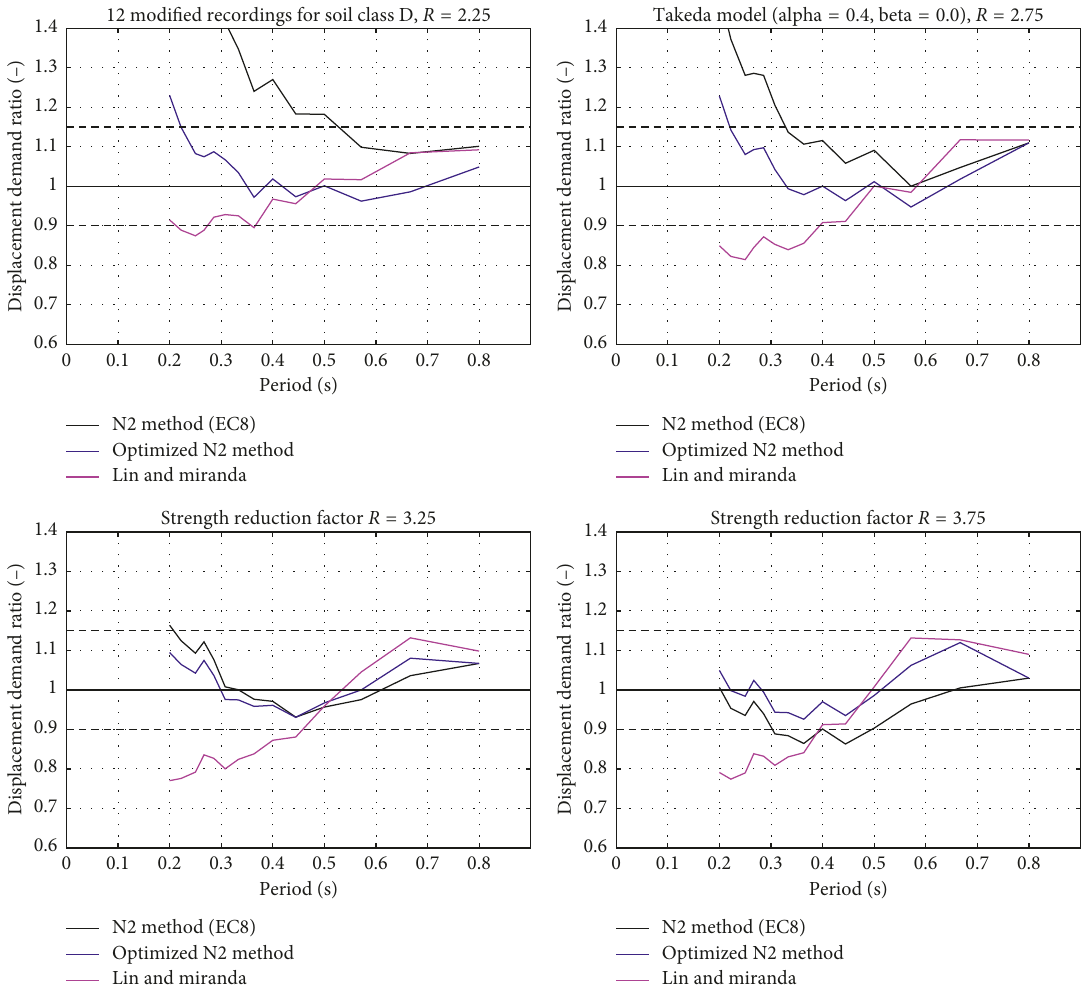
Figure 10: Assessment of the nonlinear displacement demands for soil class D and four values of strength reduction factors, R R 3 . 75. The ratio of predicted to actual (NLTHA) displacement demand is plotted with respect to the period. The plateau period range of (cid:31) the corresponding response spectrum (0.20 s to 0.80s) is considered for the assessment.